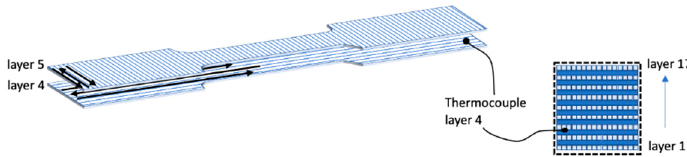
Figure 1. Sketch of the thermocouple positioning during the